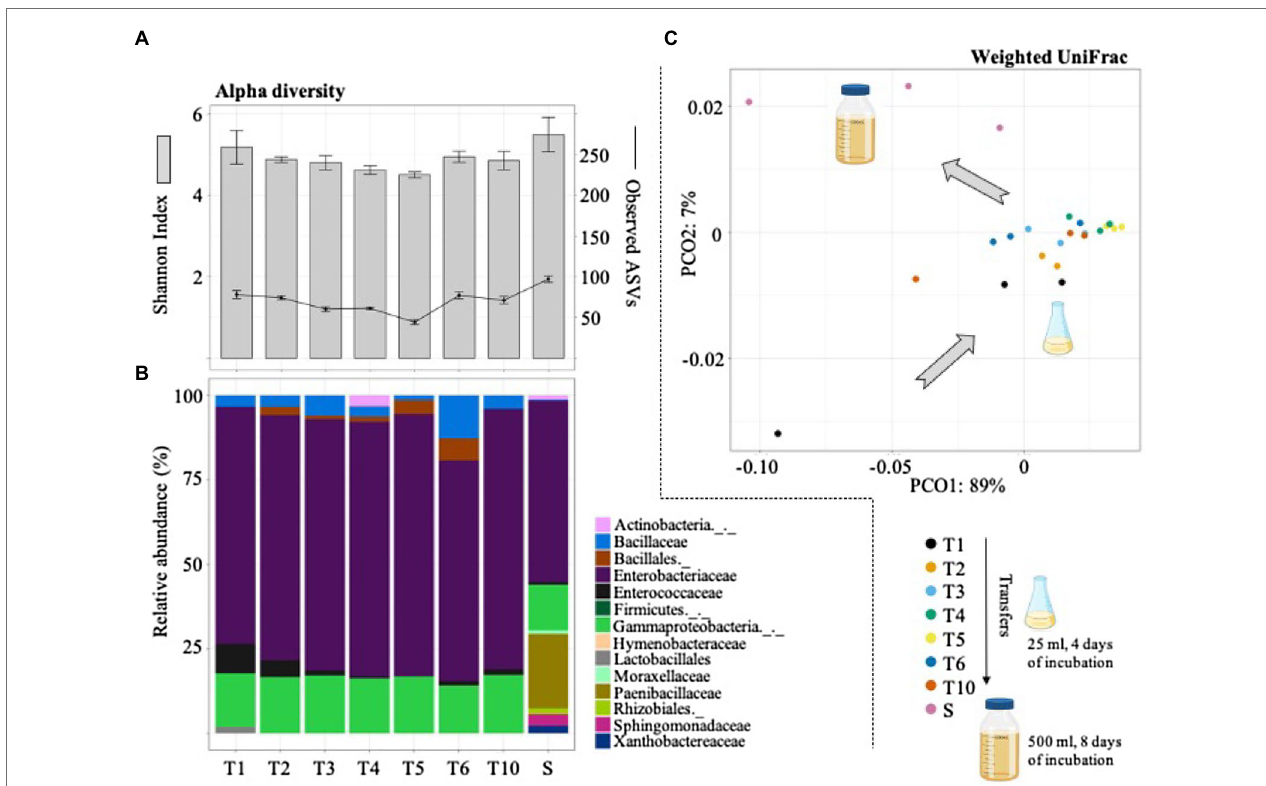
FIGURE 3 | Diversity (alpha and beta) and structural composition of the selected consortia during the sequential growth-dilution steps (T1–T6 and T10) and after its cultivation in a higher volume (i.e., scale-up growth process; S). (A) Observed amplicon sequencing variants (ASVs) and Shannon index values. Error bars represent SDs from three biological replicates. (B) Relative abundance (%) of taxa (family or higher level) detected using the SILVA database. (C) PCoA plot based on weighted UniFrac distances that shows the bacterial community similarity between the sequential transfers and the scale-up growth process (S). Icons were obtained in